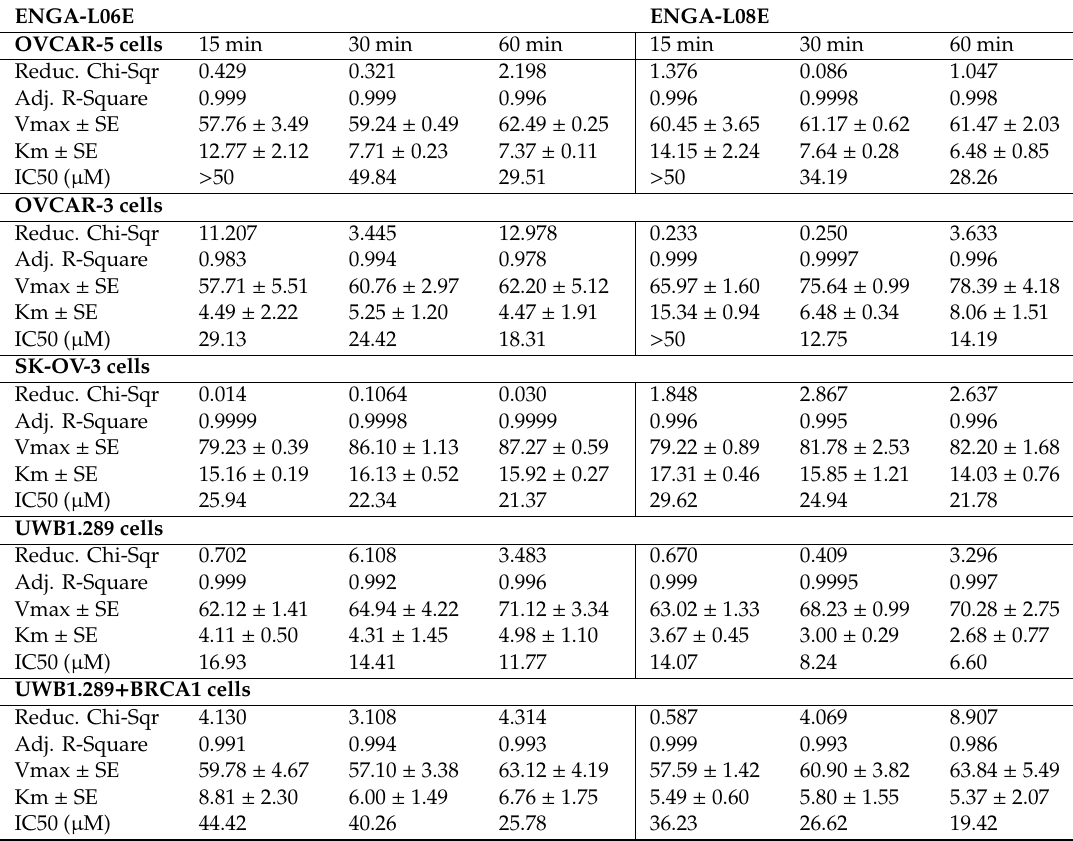
Table A2. The results of inhibitory e ff ects of ENGA-L06E and ENGA-L08E on AKT1,2 phosphorylation, in all studied cancer cell lines, as well as the corresponding kinetics according to Michaelis Menten model (significance level p < 0.01).